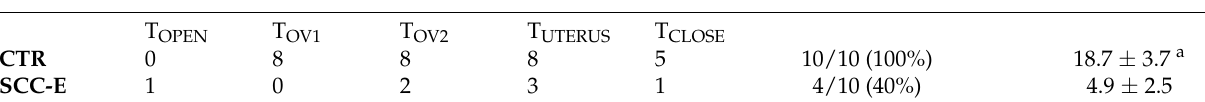
Table 2. Total number of animals that required rescue analgesia at each surgical event and mean ± SD amount of fentanyl administered in cats undergoing ovariohysterectomy with (SCC-E group) or without (CTR group) sacrococcygeal epidural ( n = 10 in each group). Animals